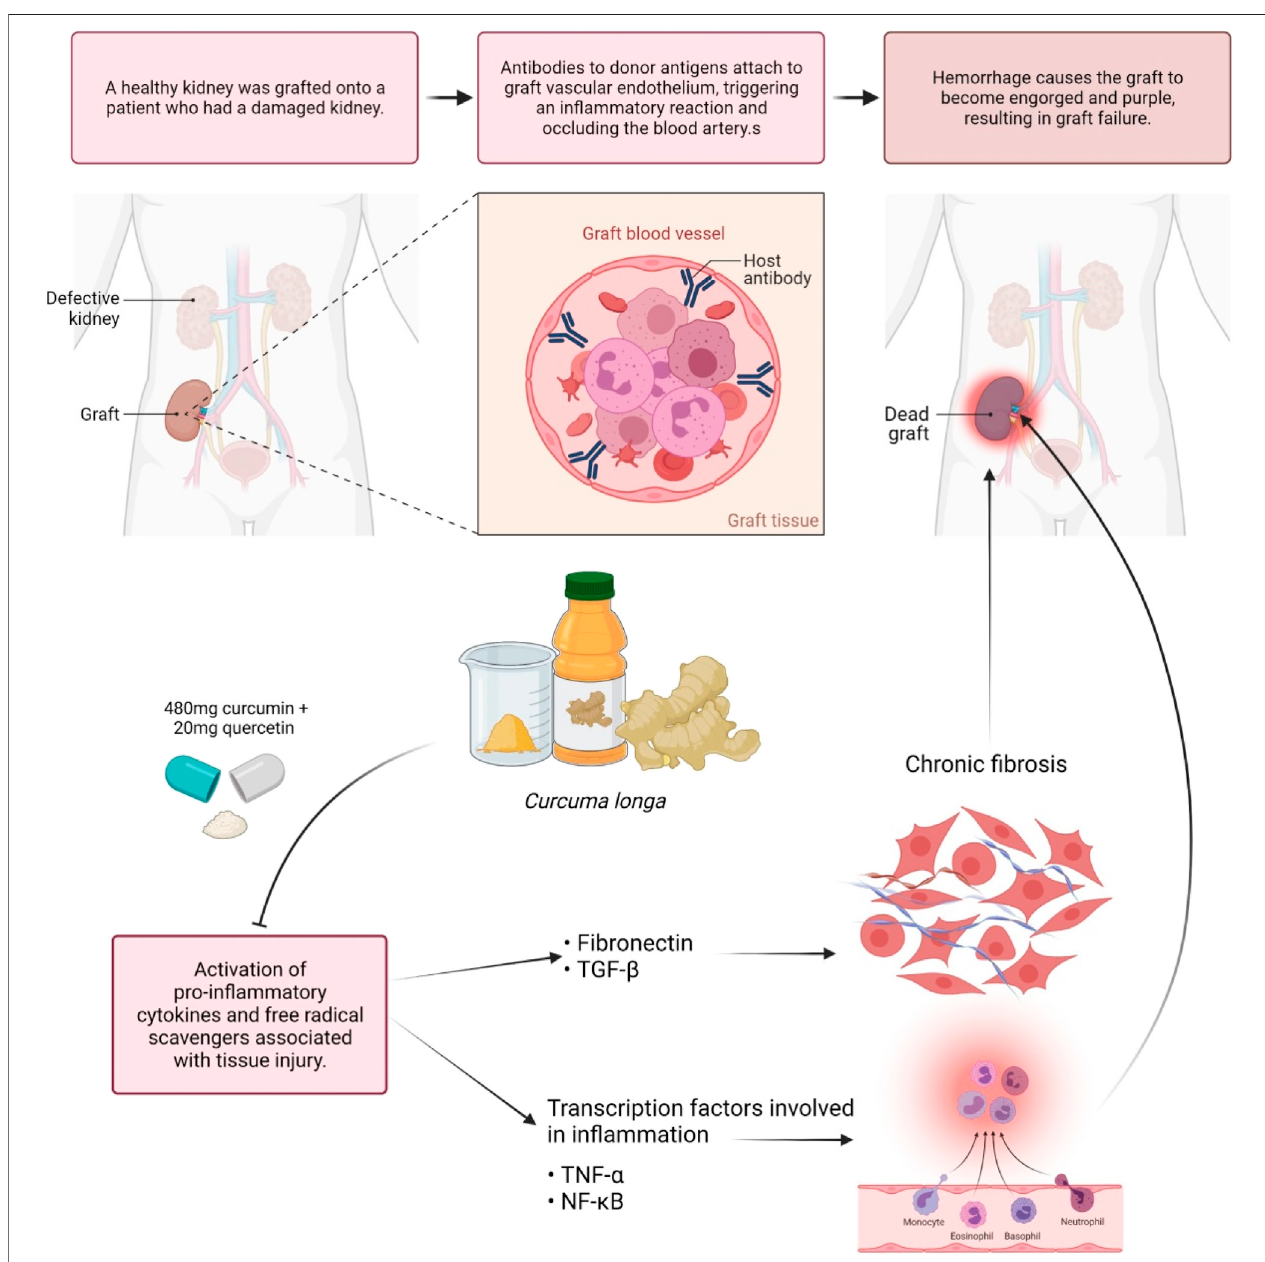
FIGURE 5 | Modulation of antibodies by curcumin. Curcumin assists in the modulation of antibodies that react with endothelium and causes hyperacute graft rejection. Blocking the expression of pro-in fl ammatory cytokines and transcription factors linked to in fl ammation and fi brosis may help to prevent dead grafts.